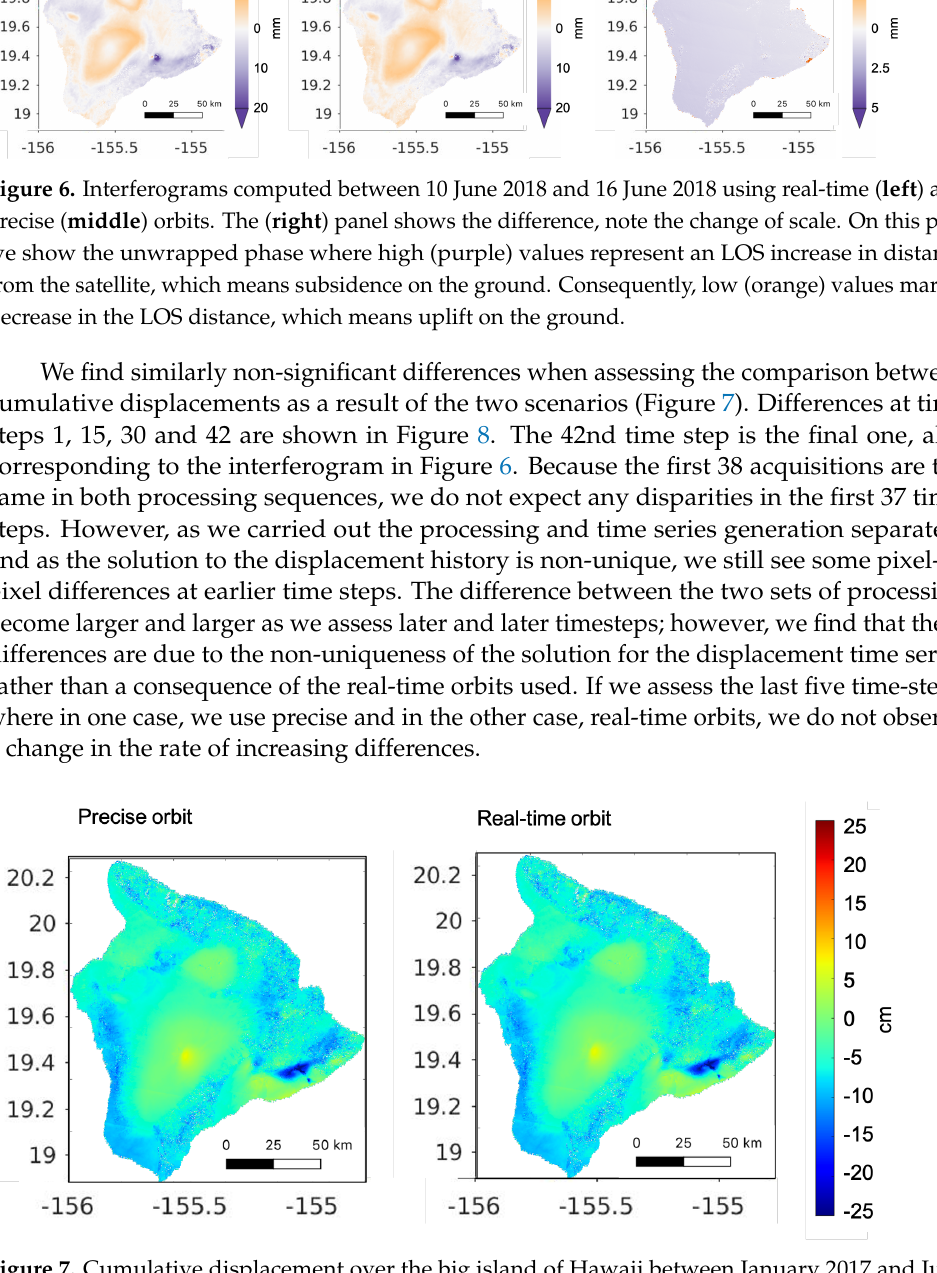
Figure 7. Cumulative displacement over the big island of Hawaii between January 2017 and June 2018 using real-time ( left ) and precise ( right )